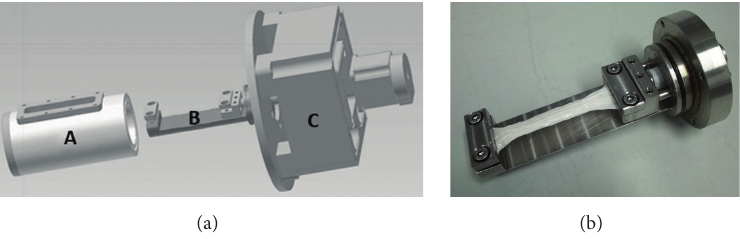
Figure 1: (a) Schematic drawing of the custom-made cyclic strain bioreactor; A: medium chamber; B: stretching device; C: motor unit. (b) Photograph of the stretching device with fixed tendon